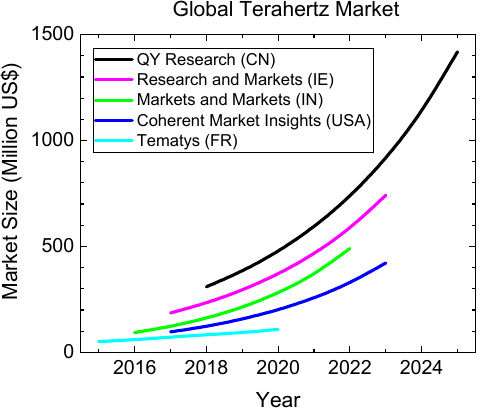
Figure 29. Global terahertz market in Million USD, according to five different analyst firms [203–207].